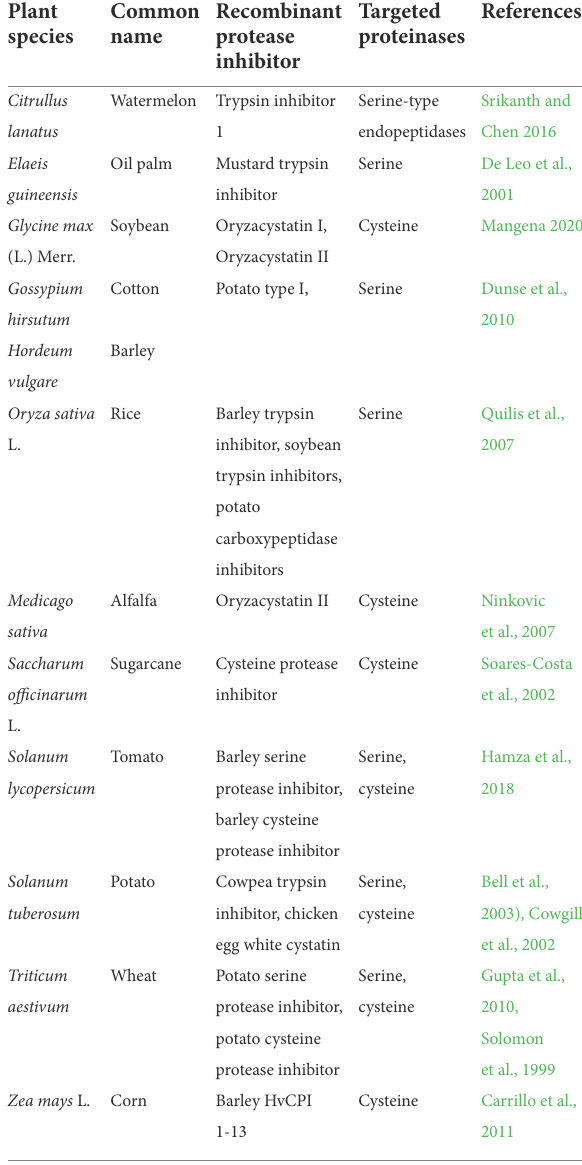
TABLE 1 Recombinant protease inhibitors expressed in transgenic plants and their targeted proteinase enzymes. Plant